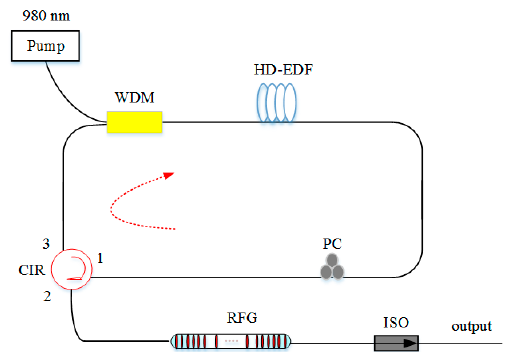
Figure 18. Setup of RFL based on the strong RFG for ultrasound detection.